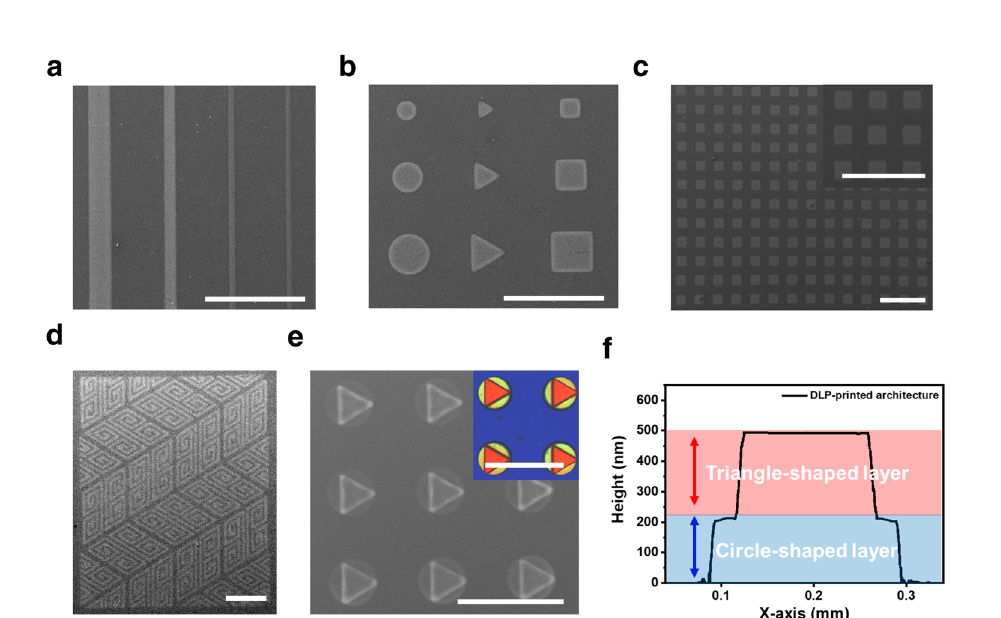
Fig. 2 | DLP printing of ChaM-based inks. a Scanning electron microscopy (SEM) image of the printed line patterns of PtS 2 -based chalcogenidometallte (ChaM) ink with widths ranging from 100 μ m to 25 μ m. b SEM image of the printed circles, squares, and triangles of PtS 2 -based ChaM ink at different scales of tens to hun- dreds of micrometres. c SEM image of hundreds of printed square array patterns withawidthof100 μ matascaleofseveralmillimetres. d SEMimageoftheprinted